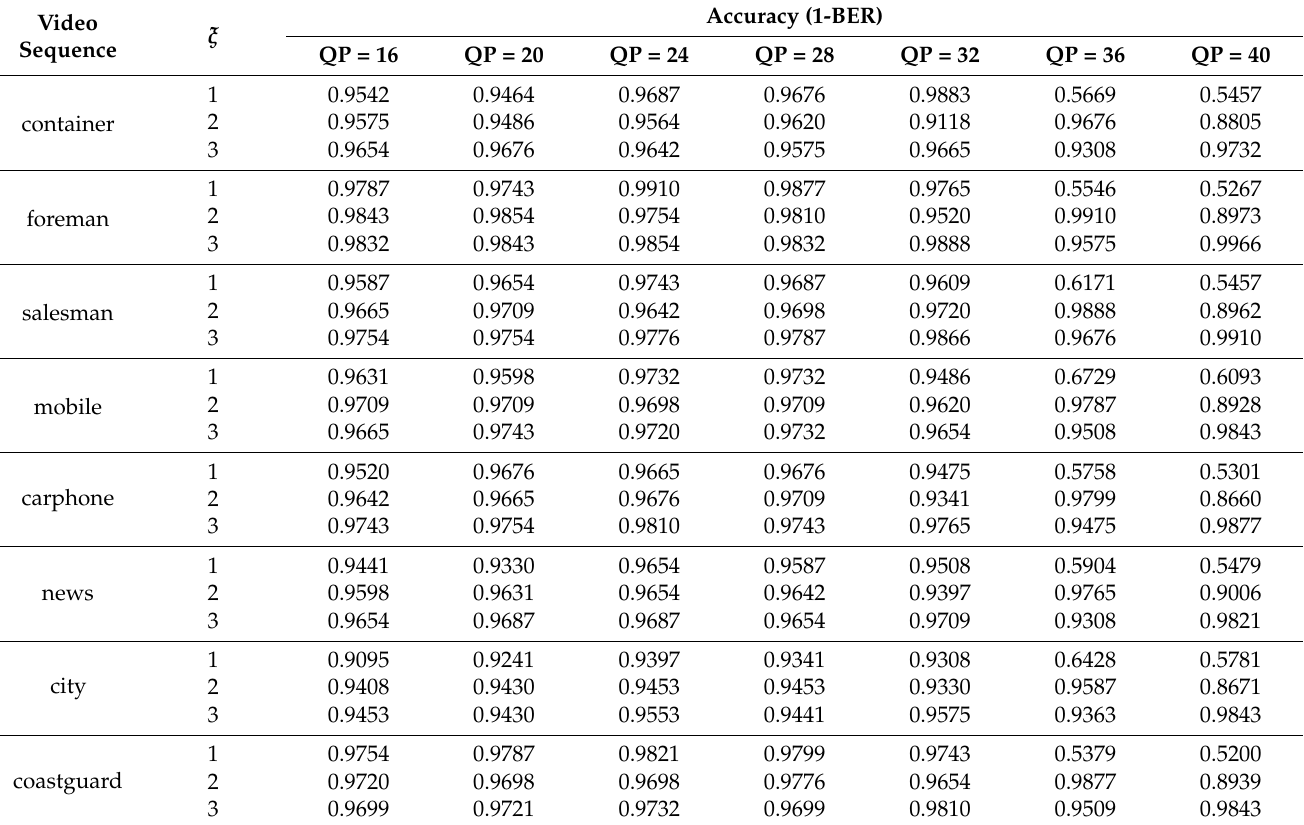
Table 2. Accuracy of information